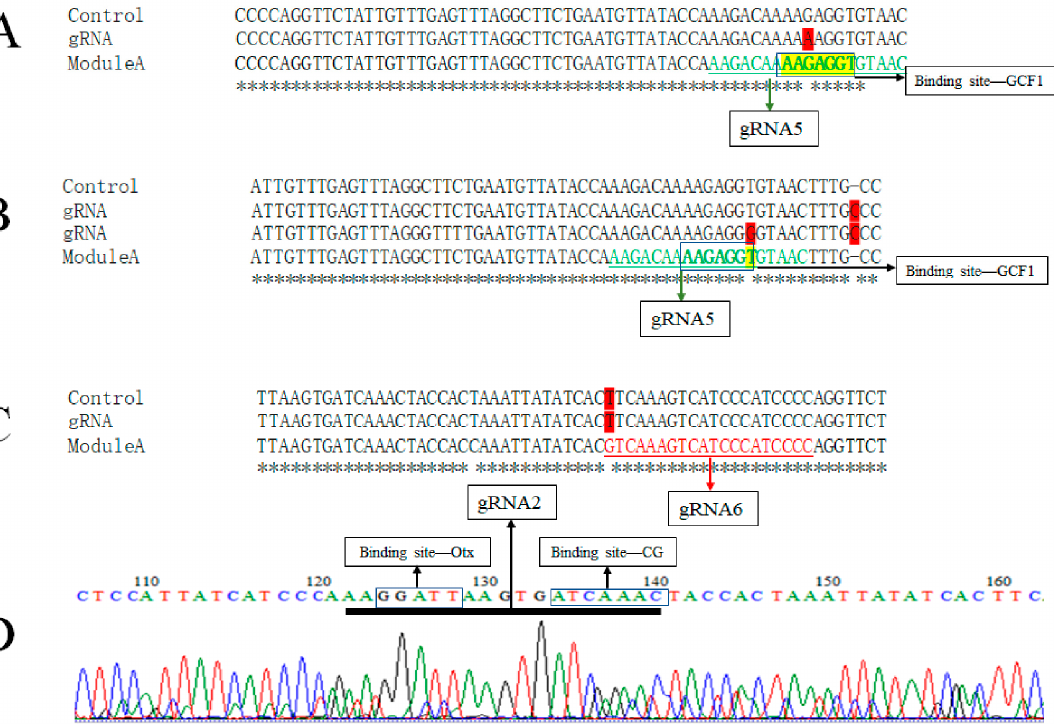
Figure 4. mRNA expression level of Endo16 detected by real-time PCR. Different letters a, b indicate significant difference for the gastrula stage ( p < 0.05), and different letters x, y indicate significant difference for the pluteus stage ( p < 0.05). The error bar indicates standard deviation ( n = 3).